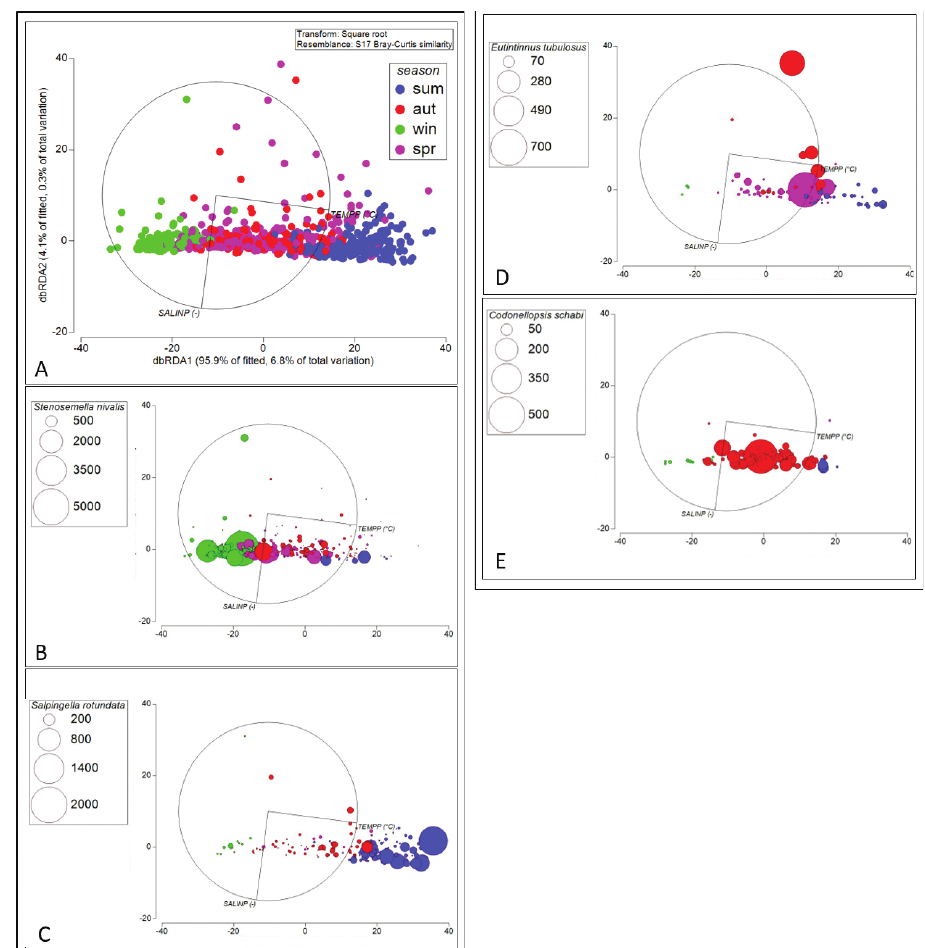
Figure 7. dbRDA (distance bases Redundancy Analysis) plot on the base of similarity in tintinnid com- position constrained by temperature and salinity with axis significances ( A ). The colours represent sam- ples collected in different seasons (blue=summer, red=autumn, green=winter, violet=spring). In the bubble plots ( B–E ), the bubble scale reports the relationship between bubble diameters and abundance measured for the most representative species: B Stenosemella nivalis C Salpingella rotundata D Eutintinnus tubulosus E Codonellopsis schabi